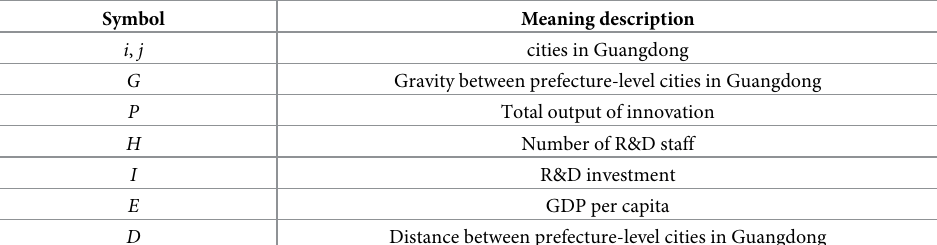
Table 1. Meaning of symbols in Eq